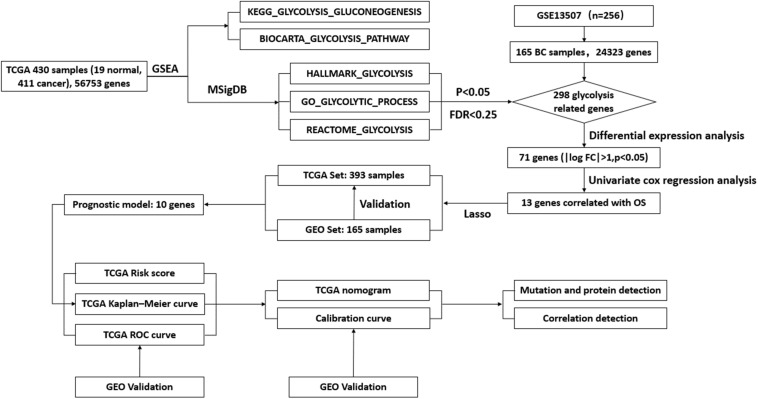
Flow chart of the key points during the process.